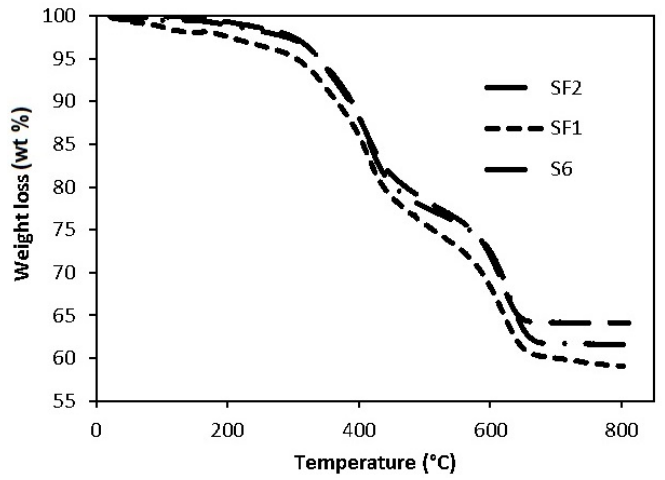
Figure 6. Comparison of the weight losses of the S6 sample, without graphene, and the SF1 and SF2 samples, with graphene.